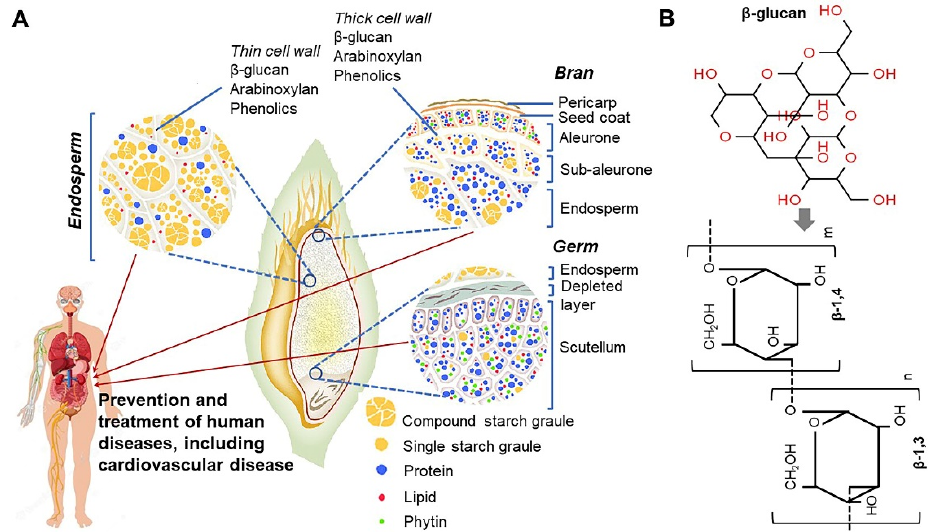
Figure 2. Structural diagram of the seed-derived cellular components from different oat tissue, including bran, germ, and endosperm, and nutrient distribution and organization within these tissues ( A ) [18,40], and chemical structure of β -glucan linked to β -1,3 and β -1,4 bridge ( B ).